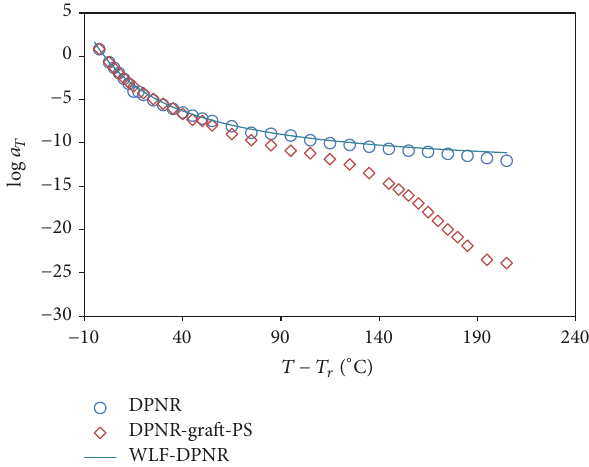
Figure 7: Temperature dependence of horizontal shift factor of DPNR and DPNR- graft -PS.